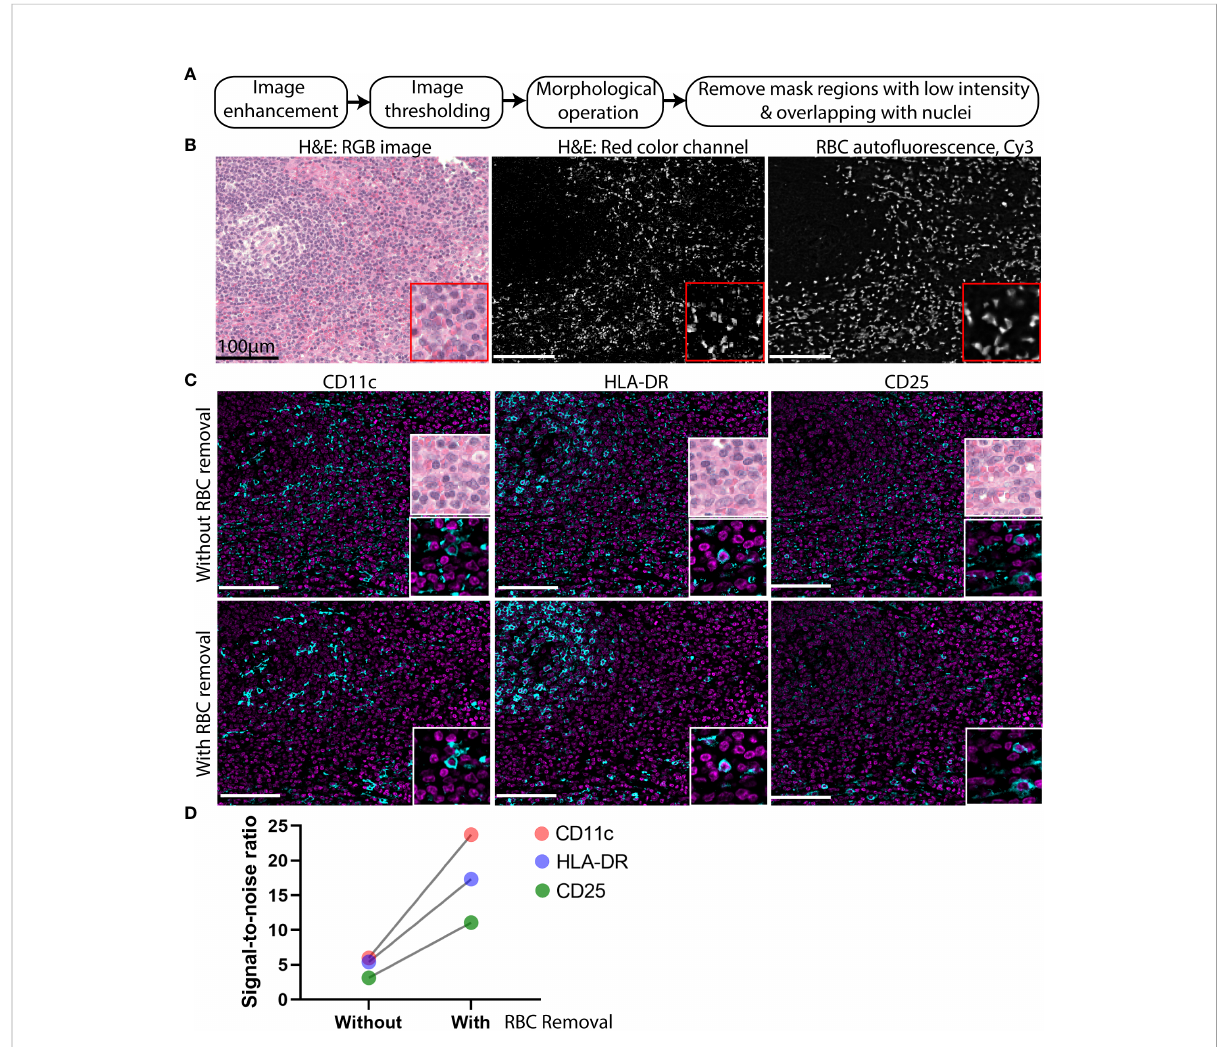
FIGURE 4 High intensity auto fl uorescence removal improves signal to noise of CODEX multiplexed imaging data. (A) Flowchart of the high intensity auto fl uorescence removal method. (B) Image of an H&E-stained cervical lymph node. Left: RBCs manifest as bright pink patches widely dispersed among the cells (nuclei indicated by purple pixels). Middle: the pink color image was digitally separated from the H&E image shown in grayscale. Right: the blank CODEX image from Cy3 channel of the same tissue section. (C) Representative images of weak markers CD11C, HLA-DR, and CD25 (cyan) overlaid with nuclear stain (magenta) without and with application of the RBC removal algorithm. (D) Signal-to-noise ratio of three markers CD11c, HLA-DR, and CD25 with and without RBC